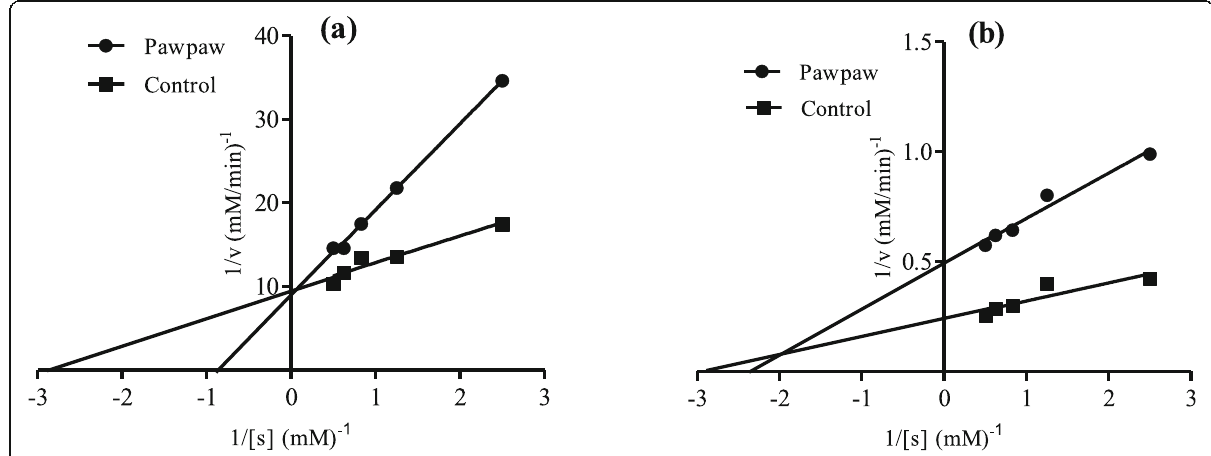
Table 2 Enzyme kinetics for the inhibition of aldose reductase and sorbitol dehydrogenase by pawpaw ( Carica papaya ) fruit extract Enzyme Sample Aldose reductase Sorbitol dehydrogenase